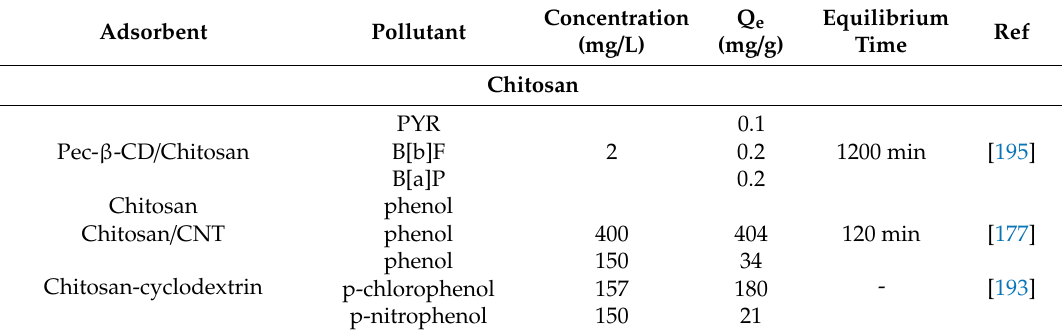
Table 8. Adsorption of PAHs and phenols using chitosan and molecularly imprinted polymers